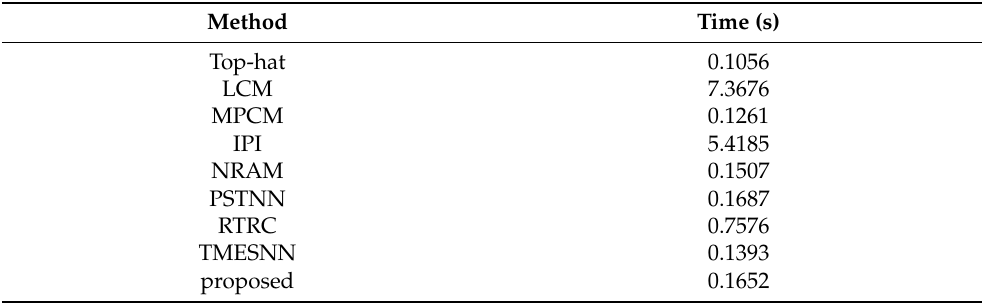
Table 7. Processing time for each image in the NUAA-SIRST dataset by different